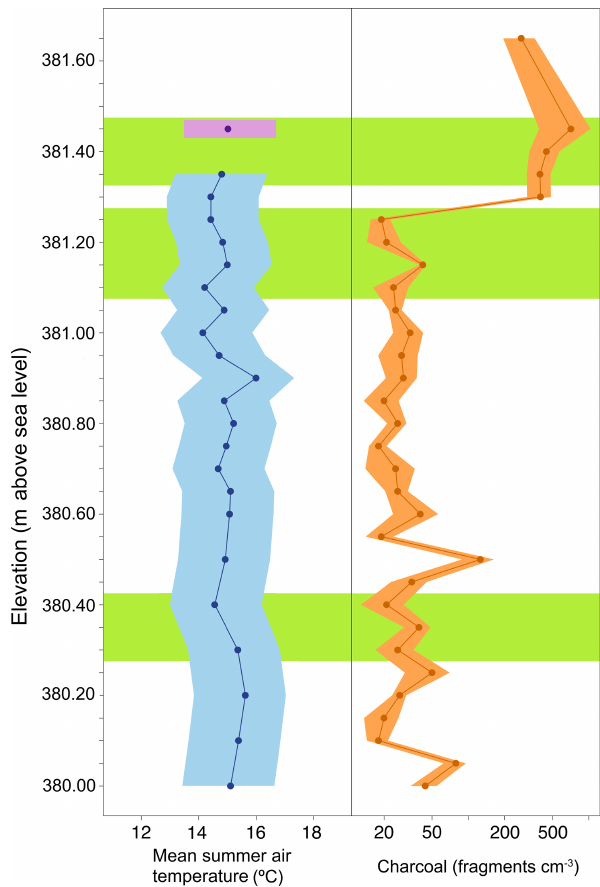
Figure 4. Reconstruction of mean summer temperature and fire for the Canadian High Arctic during the Pliocene. Mean summer air temperature reconstructed from a brGDGT-based proxy (blue; ± 2 σ ) and relative 2010 data point in approximate relative position (purple; ± 2 σ ). Charcoal counts reported as the number of frag- ments per volume (fragmentscm − 3 ) of peat (Orange ± 2 σ ). Green boxes indicate relative depths of pollen sampling. Elevation of the deposit is reported as meters above sea level. (Data: Table